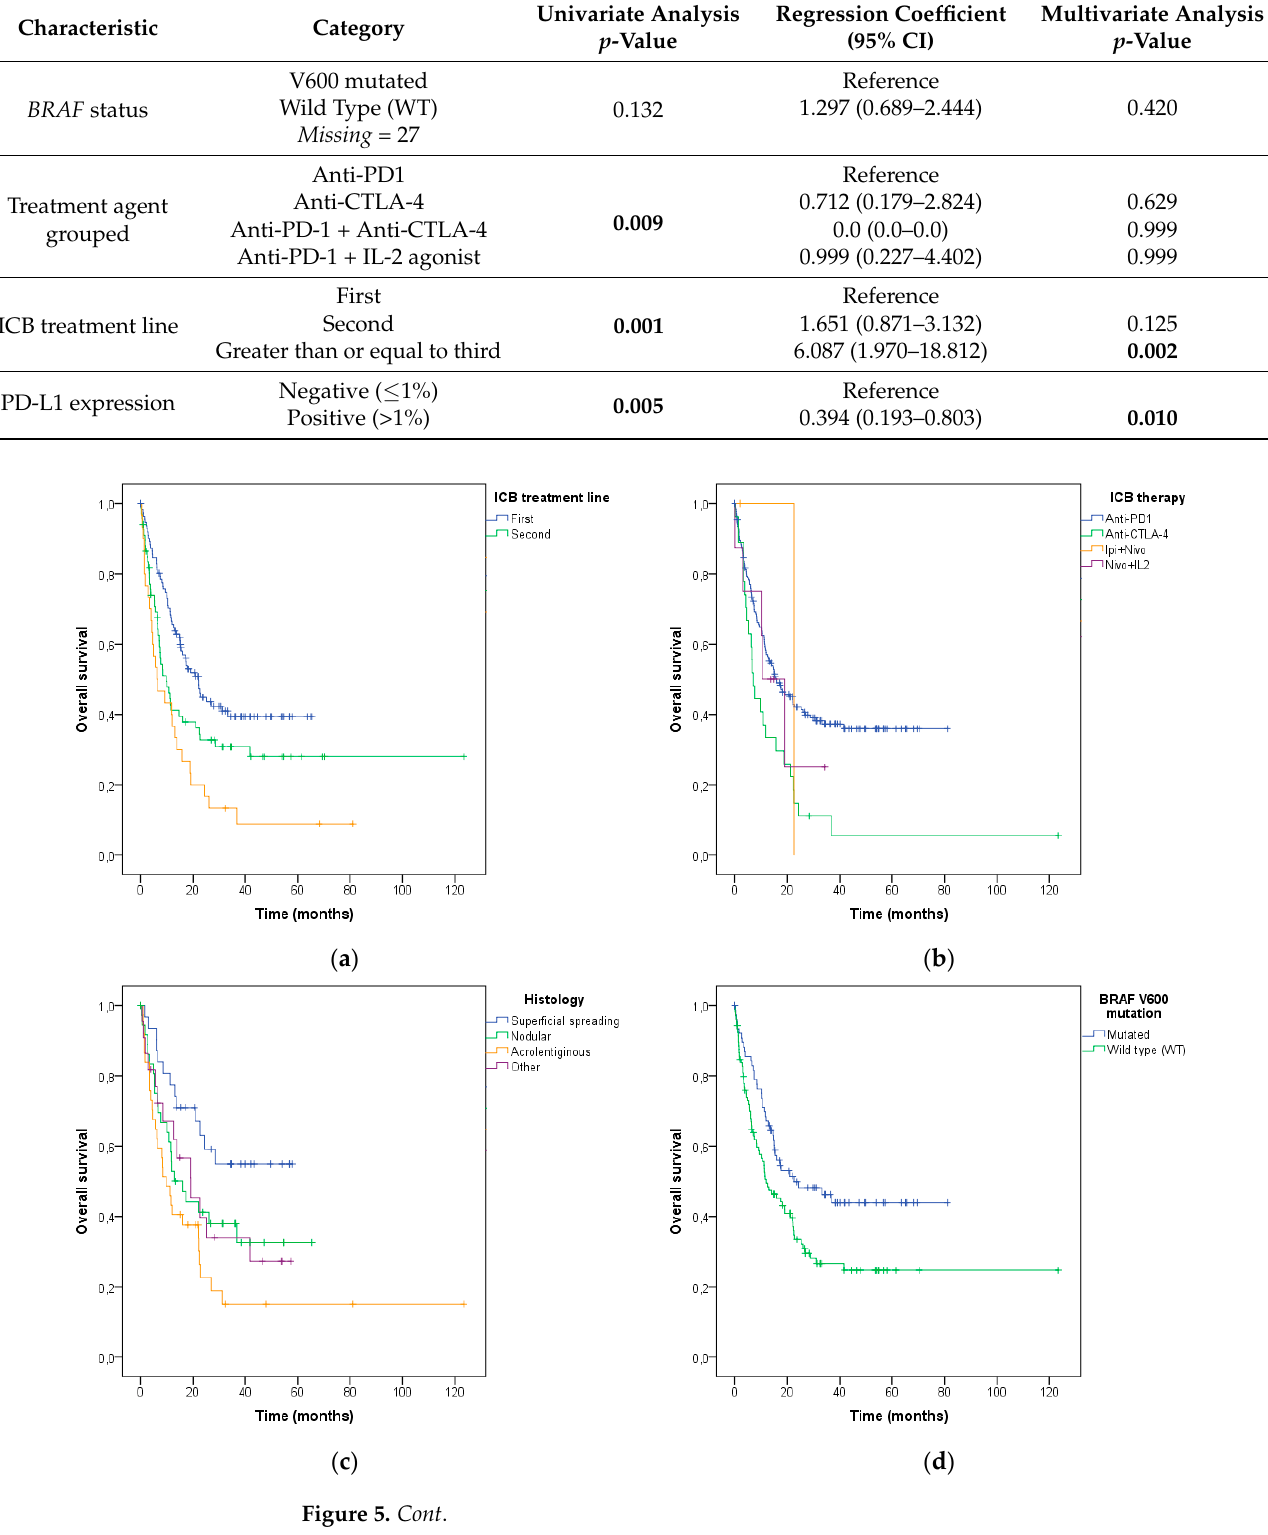
Table 3. Univariate and multivariate analyses evaluating the effect of clinical and molecular fea ‐ tures on the therapeutic response of advanced melanoma patients treated with ICB.